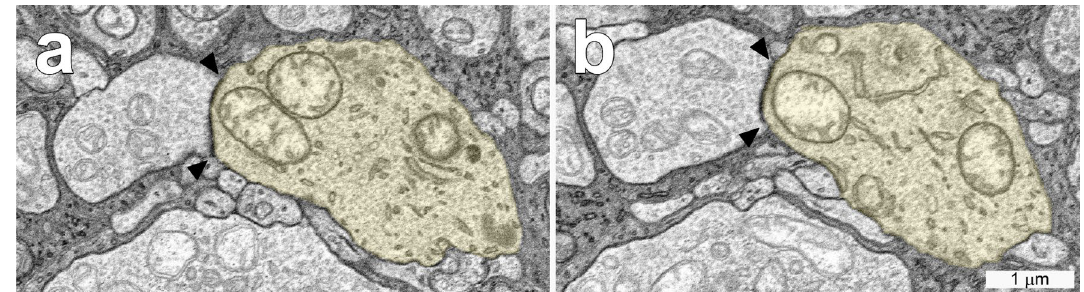
Figure 5. Displaced M1 ipRGC 11345 in the nasal volume (yellow) received input from a bipolar cell axon (11782) at a large non-ribbon synapse ( ▲ ). The sections were selected from a series of 18; panel ( a ) Z = 1885, panel ( b ) Z =